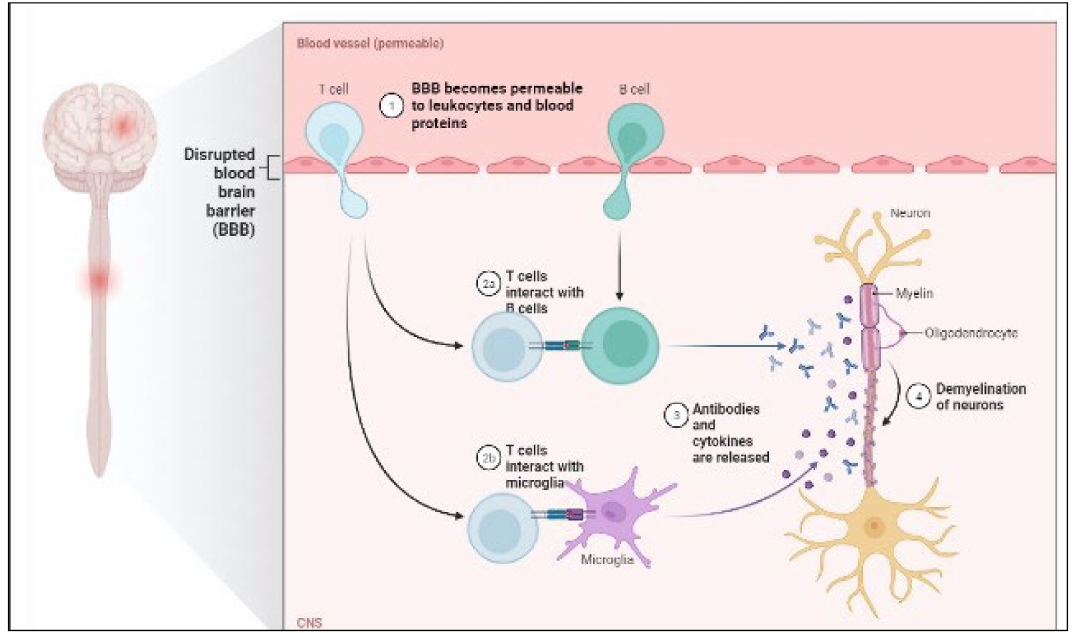
Figure 3. Pathology of